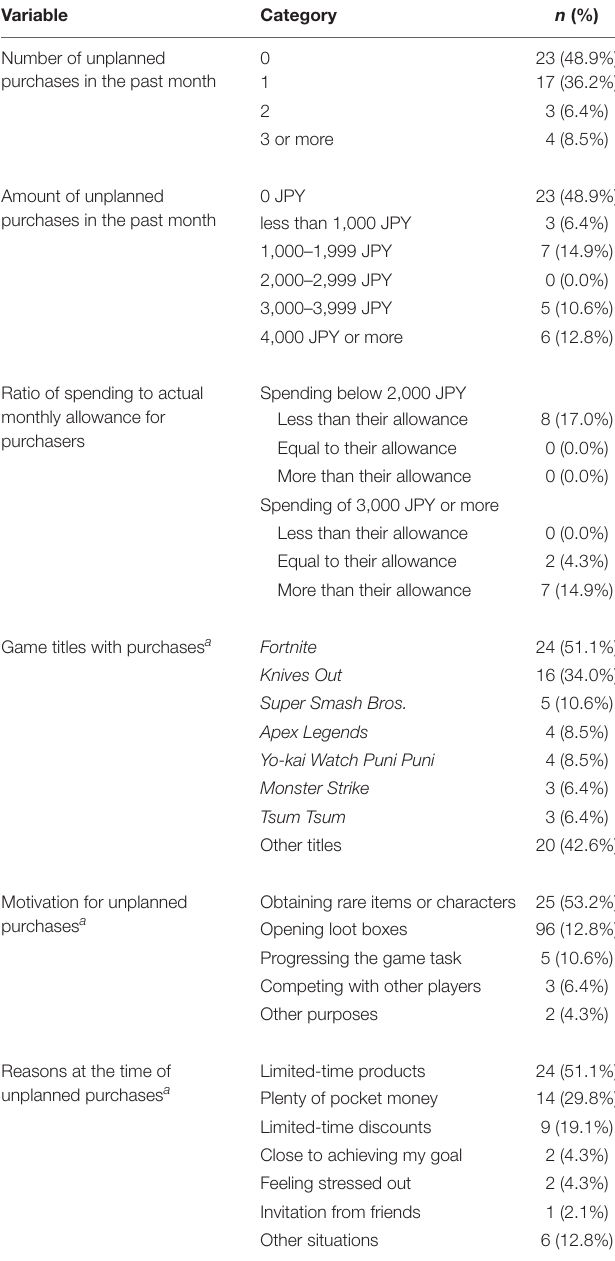
TABLE 2 | Unplanned purchase user profiles ( n =